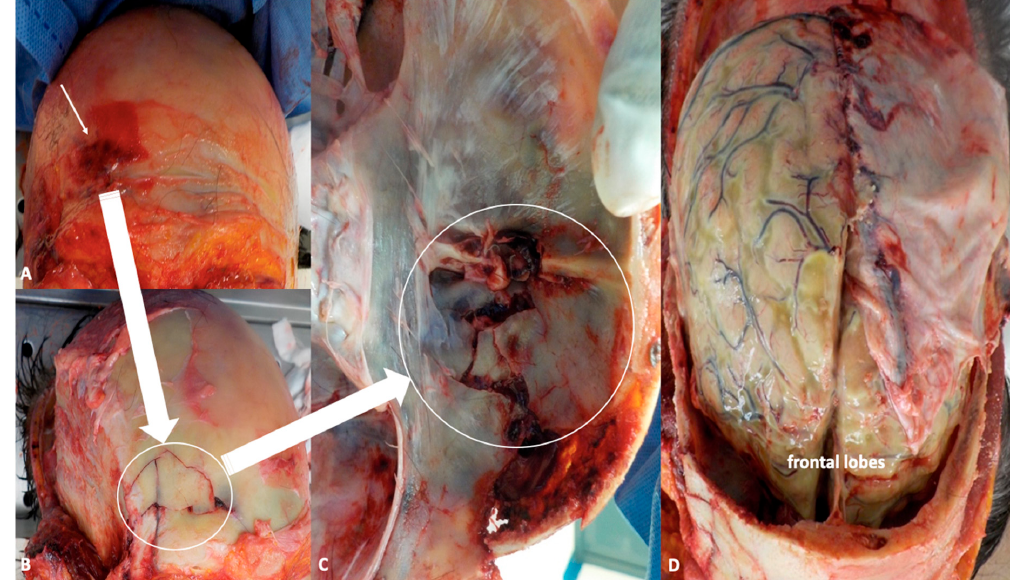
Figure 2. ( A , B ) Autoptical findings: exposure of the skull by facial skin overturning. This technique allows to evaluate the periorbital region as well as zygomatic and nasal bones (white arrow indicates fractures of the frontal region). ( C ) Fractures of the anterior fossa are easily detectable after removal of the brain (white arrow), while inspecting the basal skull. ( D ) In situ inspection of the brain. The leptomeninges shows frank green color owing to the presence of purulent material stratified under the meninges.